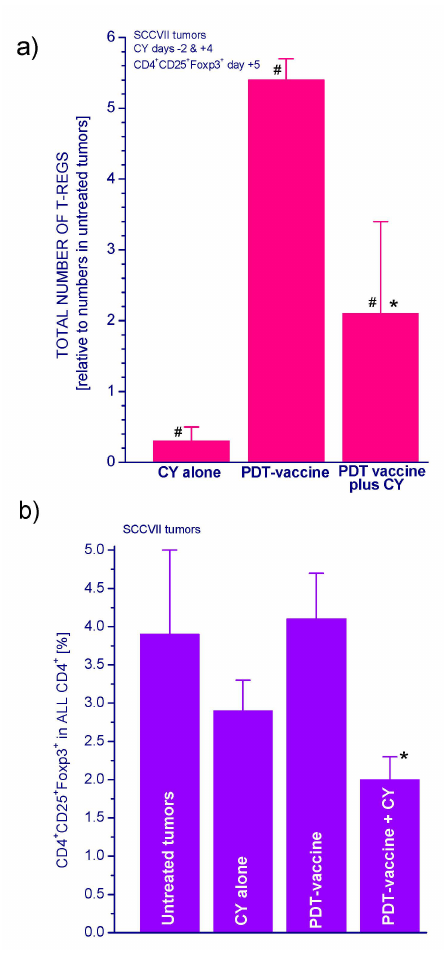
Figure 4. Treg numbers in untreated and treated SCCVII tumors and the effect of cyclophosphamide. Mice with SCCVII tumors were treated with PDT vaccine as described for Figure 1 and received two cyclophosphamide injections (50 mg/kg) as described for Figure 3. Mice were sacrificed five days post vaccination and cell suspensions from their tumors were stained with fluorophore-conjugated antibodies to identify Tregs as CD4 + CD25 + Foxp3 + cells using flow cytometry. The data are presented ( a ) as relative values (compared to untreated tumor) of total number of Tregs per tumor and ( b ) as percent of Tregs in helper T cell population. Each treatment group consisted of four mice. # Statistically significant difference from untreated tumors group ( p < 0.05); * statistically significant difference from vaccine alone group ( p < 0.05).